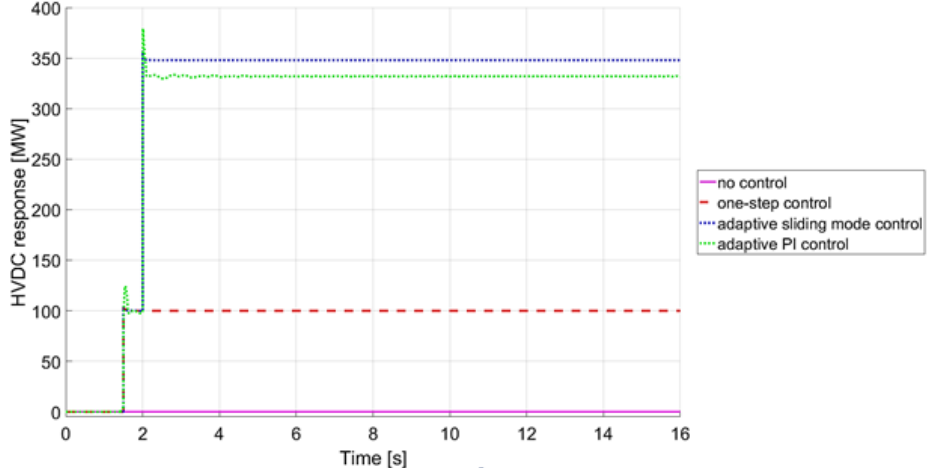
Figure 11. HVDC active power in Configuration II in case of big